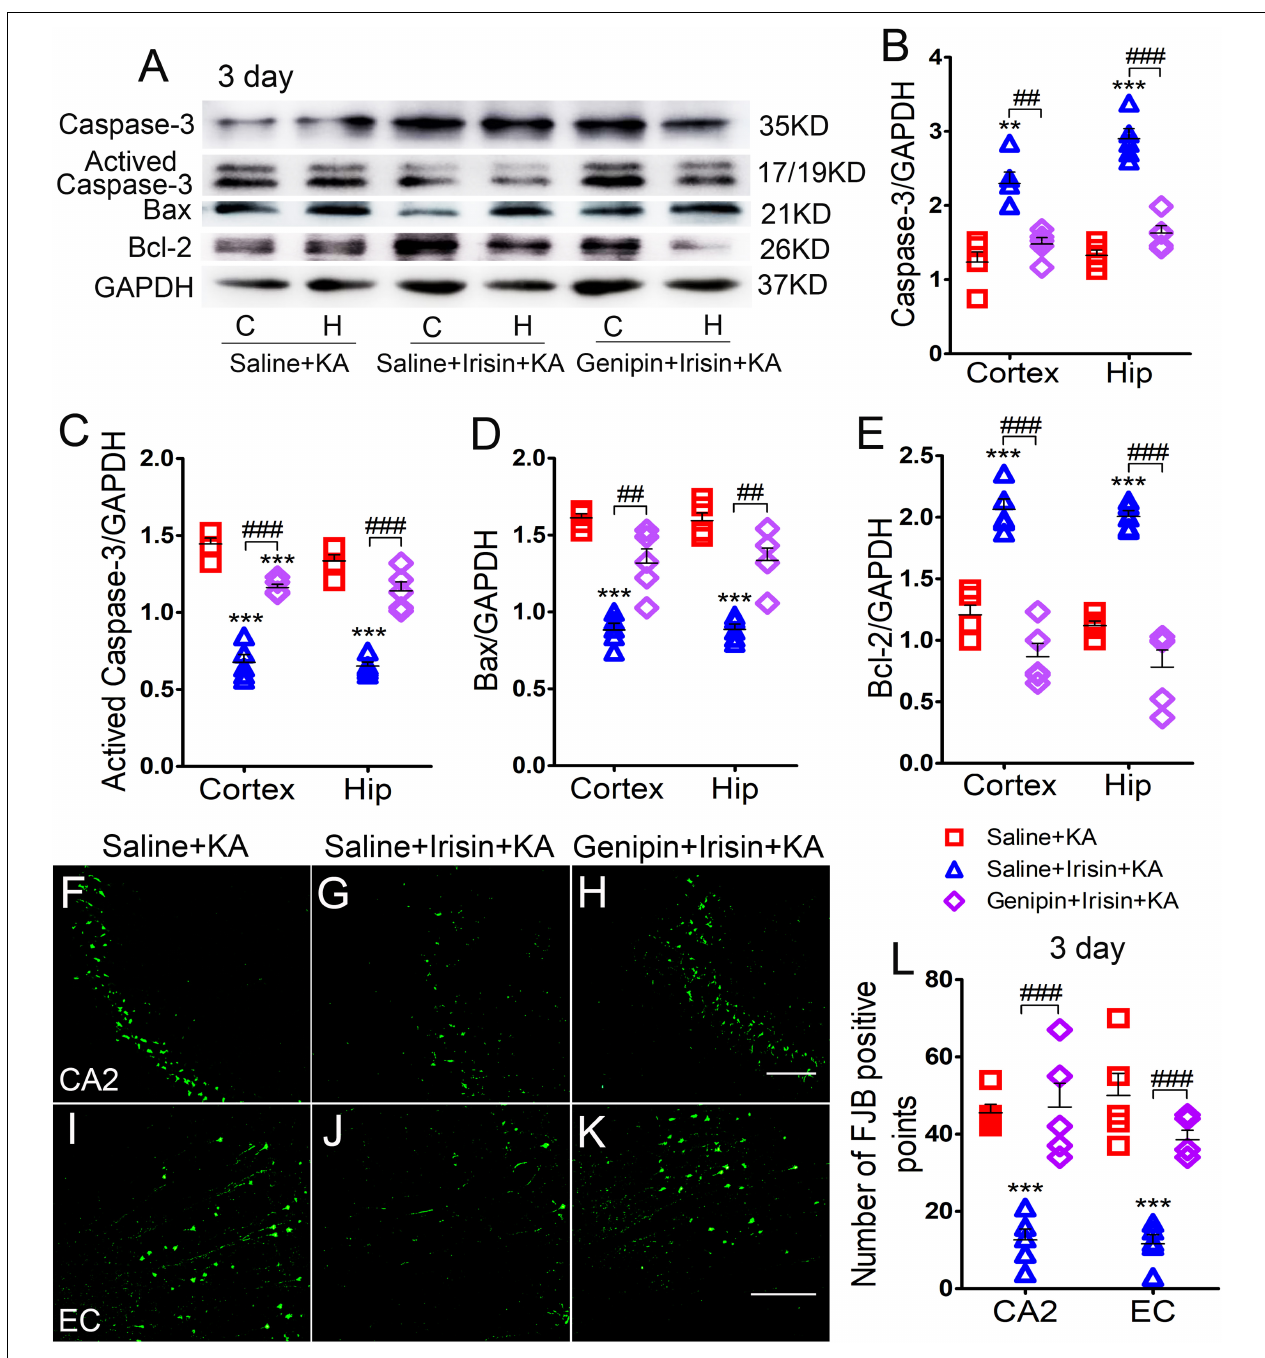
FIGURE 6 | Genipin reversed the effects of irisin on KA-induced apoptosis and neuronal degeneration. (A–E) The immunoreactivity of caspase-3, activated caspase-3, Bax, and Bcl-2 ( n = 5/group). (F–L) Positive signals of FJB in CA2 and EC ( n = 5/group). Bar = 50 µ m. ** P < 0.01, *** P < 0.001 compared with controls; ## P < 0.01, ### P < 0.001 compared with each other (One-way ANOVA with Dunnett’s T3 post hoc test). C, cortex; EC, entorhinal cortex; H/Hip, hippocampus; CA2, cornu ammonis 2; Bcl-2, B-cell lymphoma-2; Bax, Bcl-2-Associated X.